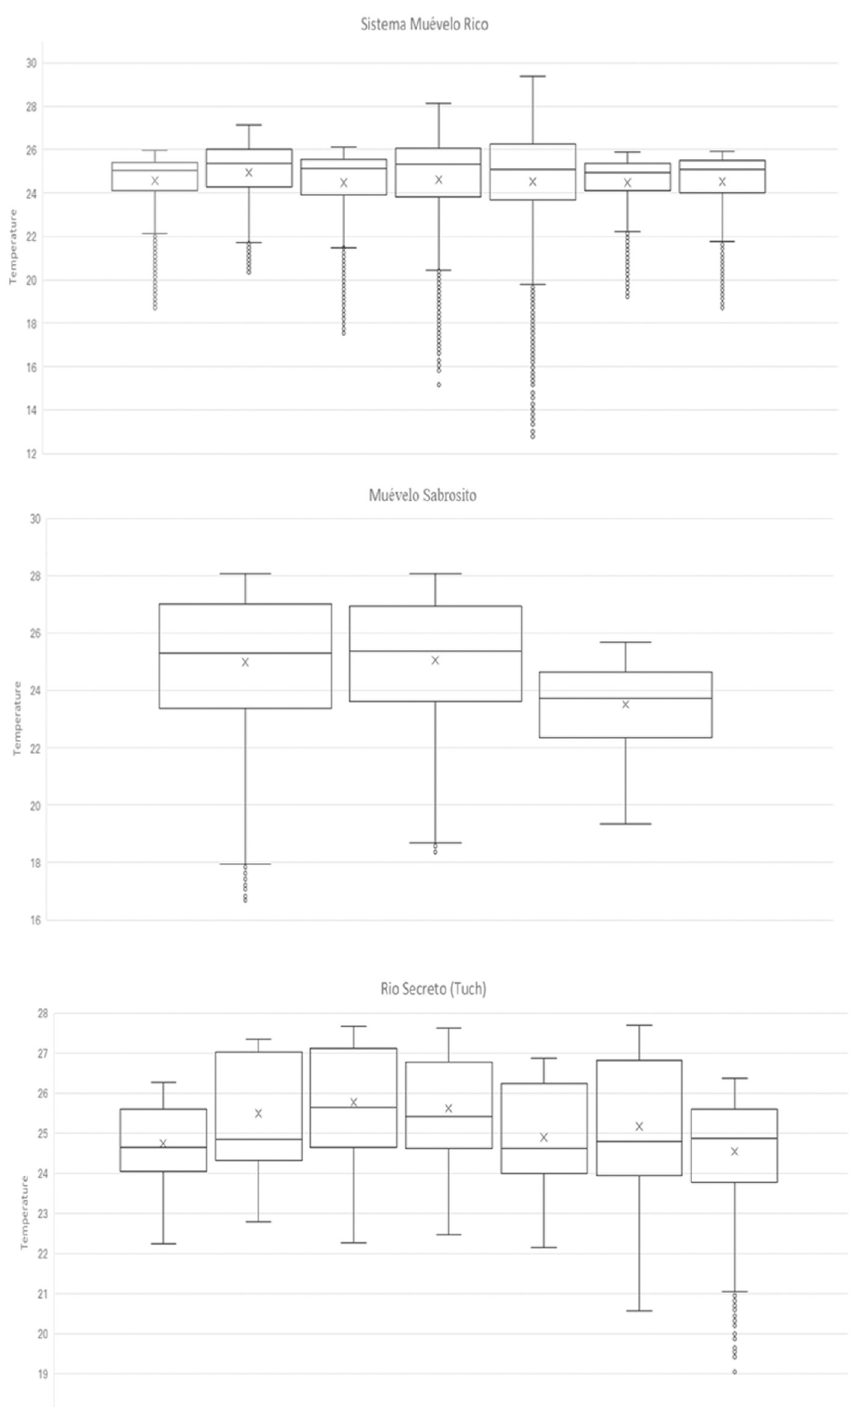
Fig 2. Box and whiskers plots of temperature variation in the individual stations. Order is by number of the station. X’s indicate means; the horizontal line within the box, the median; the boxes, the inter-quartile range; whiskers, 1.5 times the interquartile range beyond the box; and small circles are